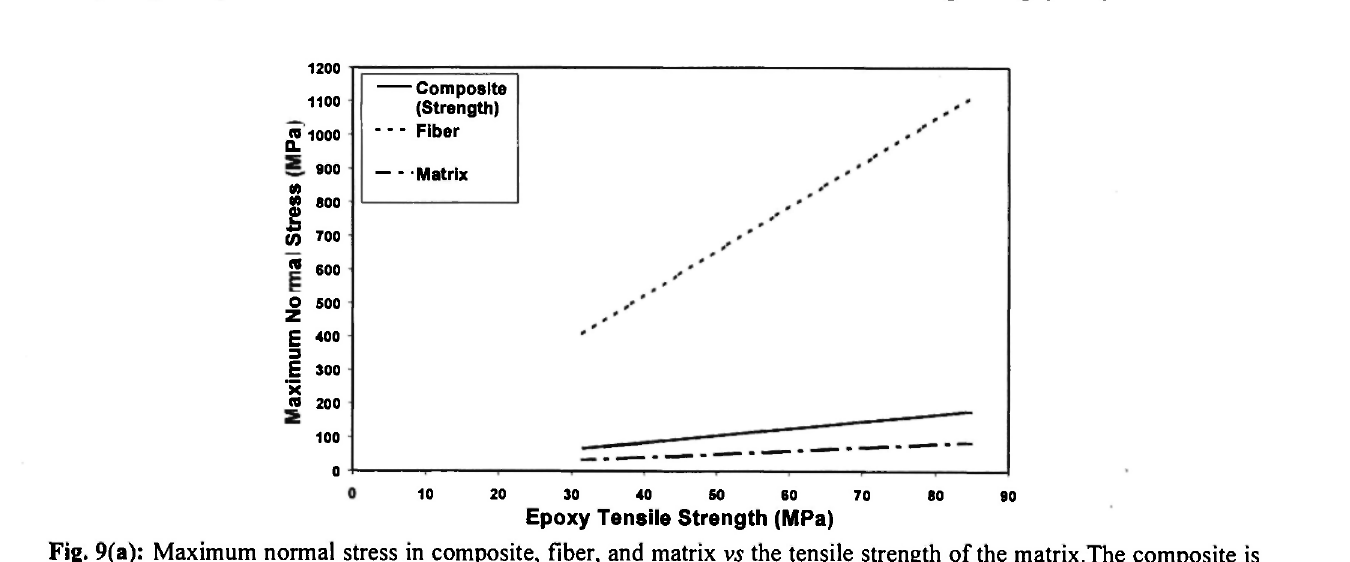
Fig. 9(a): Maximum normal stress in composite, fiber, and matrix vi the tensile strength of the matrix.The composite is loaded in wale direction.The geometric parameters used are: cM).0445cm, D y =177.8(Tex),^=0.45, p f =2.54g/cm 3 , C=2.51oop/cm, fF=2.51oop/cm, i=0.06cm.